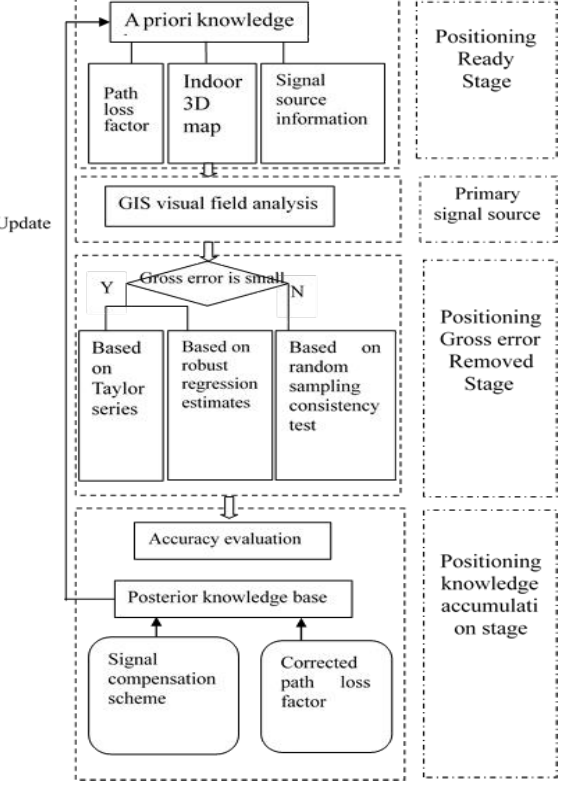
Figure 2.1 Flow chart for optimization of positioning accuracy based on signal source